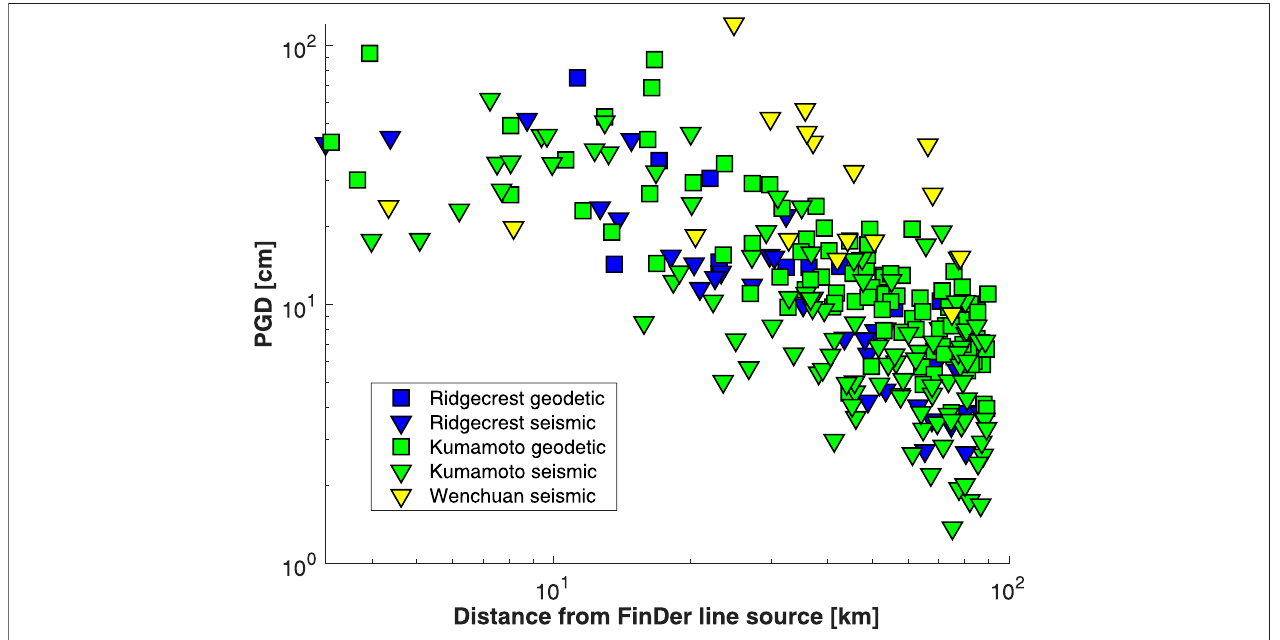
FIGURE4| Faultslip,D,estimatedfromthebackprojectionof fi nalPGDamplitudesontothe fi nalFinDerline-source( Figure2 )forthea)Ridgecrest,b)Kumamoto, and c) Wenchuan earthquakes. Gray dots show surface slip pro fi les published by various authorsasgivenin the legends. For Ridgecrest and Kumamoto,the published values show lateral slip, while for Wenchuan, they show net slip. Note that the backprojected slip values and epicenters are relative to the respective FinDer line-source model, oriented as indicated on the plots.